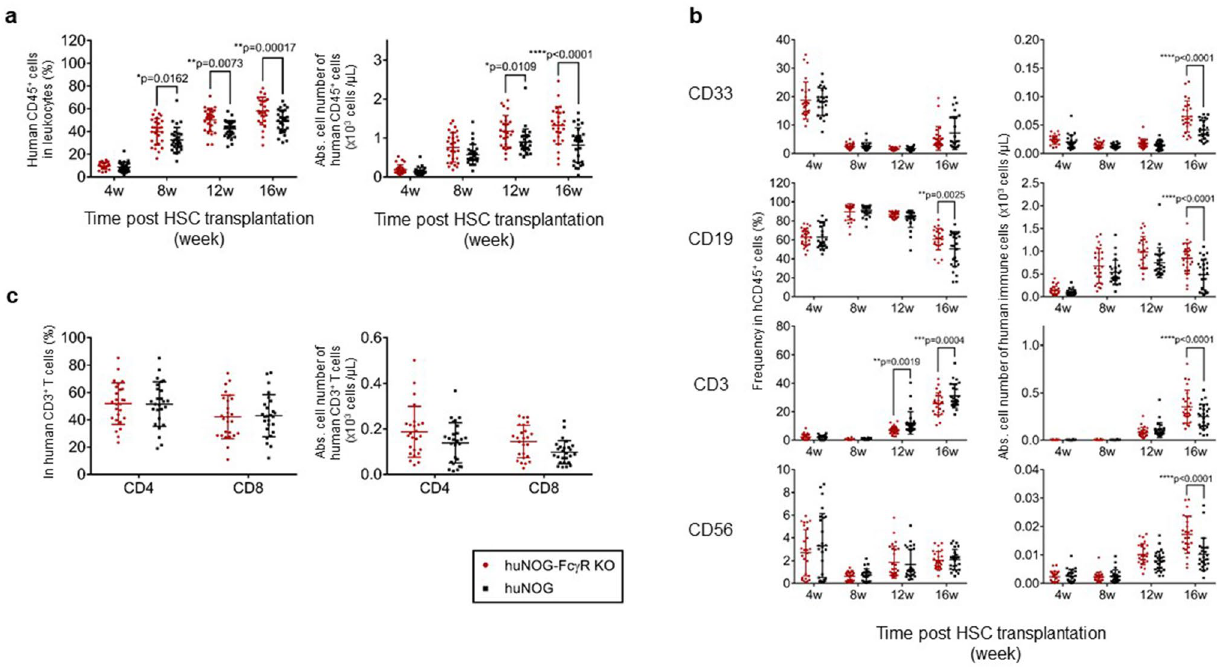
Figure 1. Human hematopoiesis in NOG-FcγR −/− mice. Development of human leukocytes was examined using PB by flow cytometry at the indicated time points. ( a ) Frequency of human CD45 + cells in total leukocytes and the absolute cell number. PB was collected from huNOG (black square, n = 28) or huNOG-FcγR −/− mice (red circle, n = 27) at the indicated time points after HSC transplantation and was analyzed by flow cytometry. ( b ) Detection of human CD33 + myeloid cells, CD19 + B cells, CD3 + T cells, and CD56 + natural killer (NK) cells. The frequencies in CD45 + cells were obtained by flow cytometry analysis and multiplied by the CD45 + cell numbers in ( a ) to calculate the cell numbers of each fraction. huNOG (black square, n = 26) or huNOG-FcγR −/− mice (red circle, n = 26). ( c ) Proportion and cell number of CD4 + and CD8 + T cells. Cumulative data from three independent experiments using HSCs from three different donors are shown with the average and standard deviation (SD) bars. Asterisks indicate statistical significance by a repeated measure ANOVA with Sidak’s multiple comparison test (*p < 0.05, **p < 0.01, ***p < 0.001, ****p <